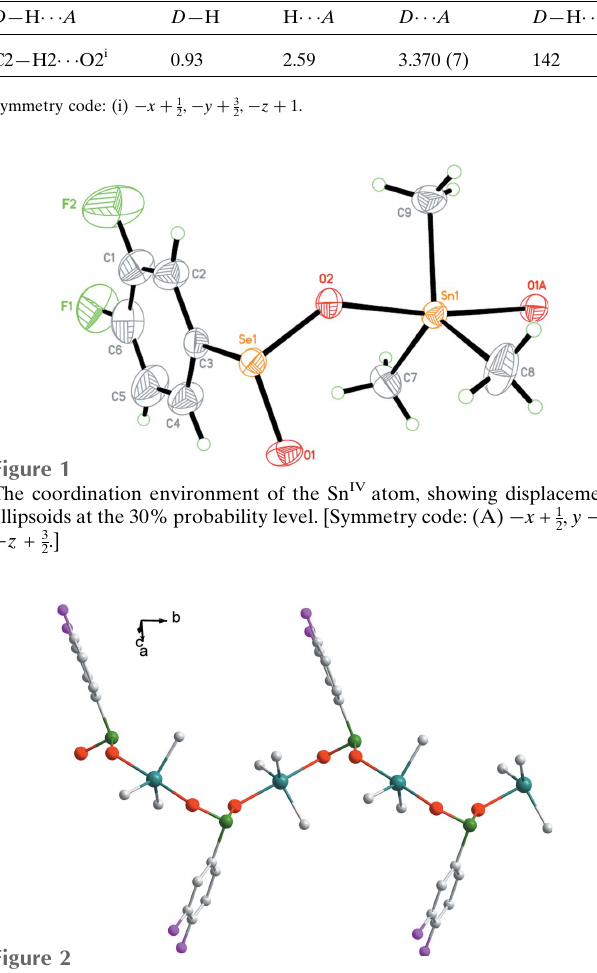
Table 1 Hydrogen-bond geometry (A˚ , (cid:4) ).